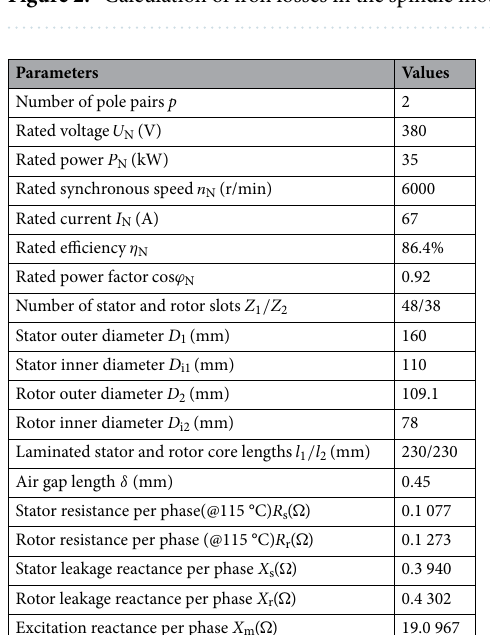
Figure 2. Calculation of iron losses in the spindle motor.